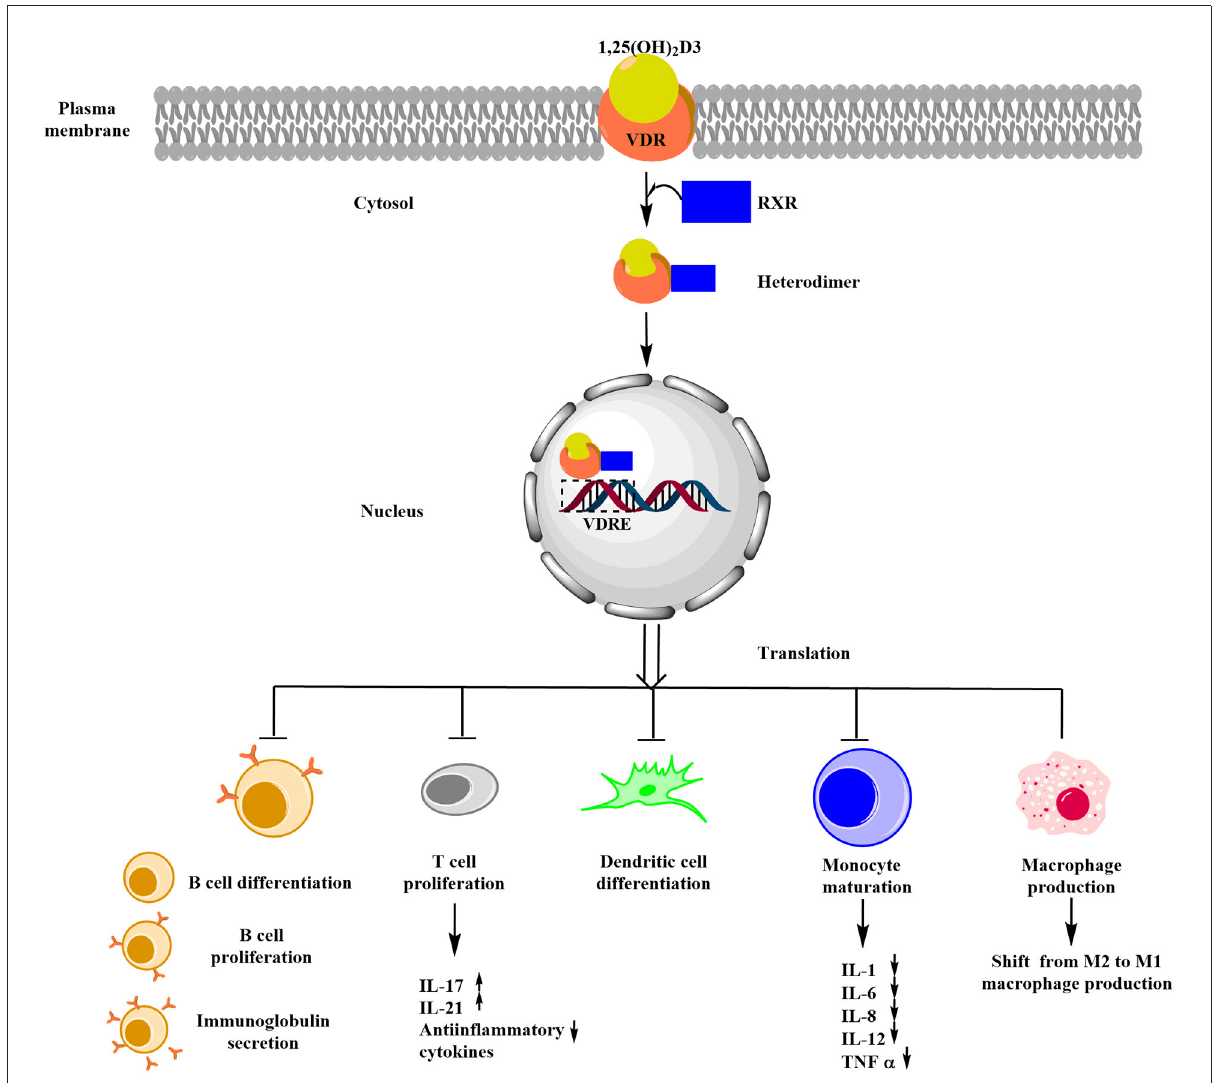
FIGURE4 Schematic representation of the role of vitamin D in immune regulation in CD. Upon binding of vitamin D3 with VDR, RXR is recruited and results in the formation of a heterodimer known as VDR-RXR complex, whose translated product (formed by binding of the heterodimer with VDRE) exerts immune modulation by inhibiting differentiation and proliferation of B-cell, T-cell, and dendritic cells and also inhibits immunoglobulin